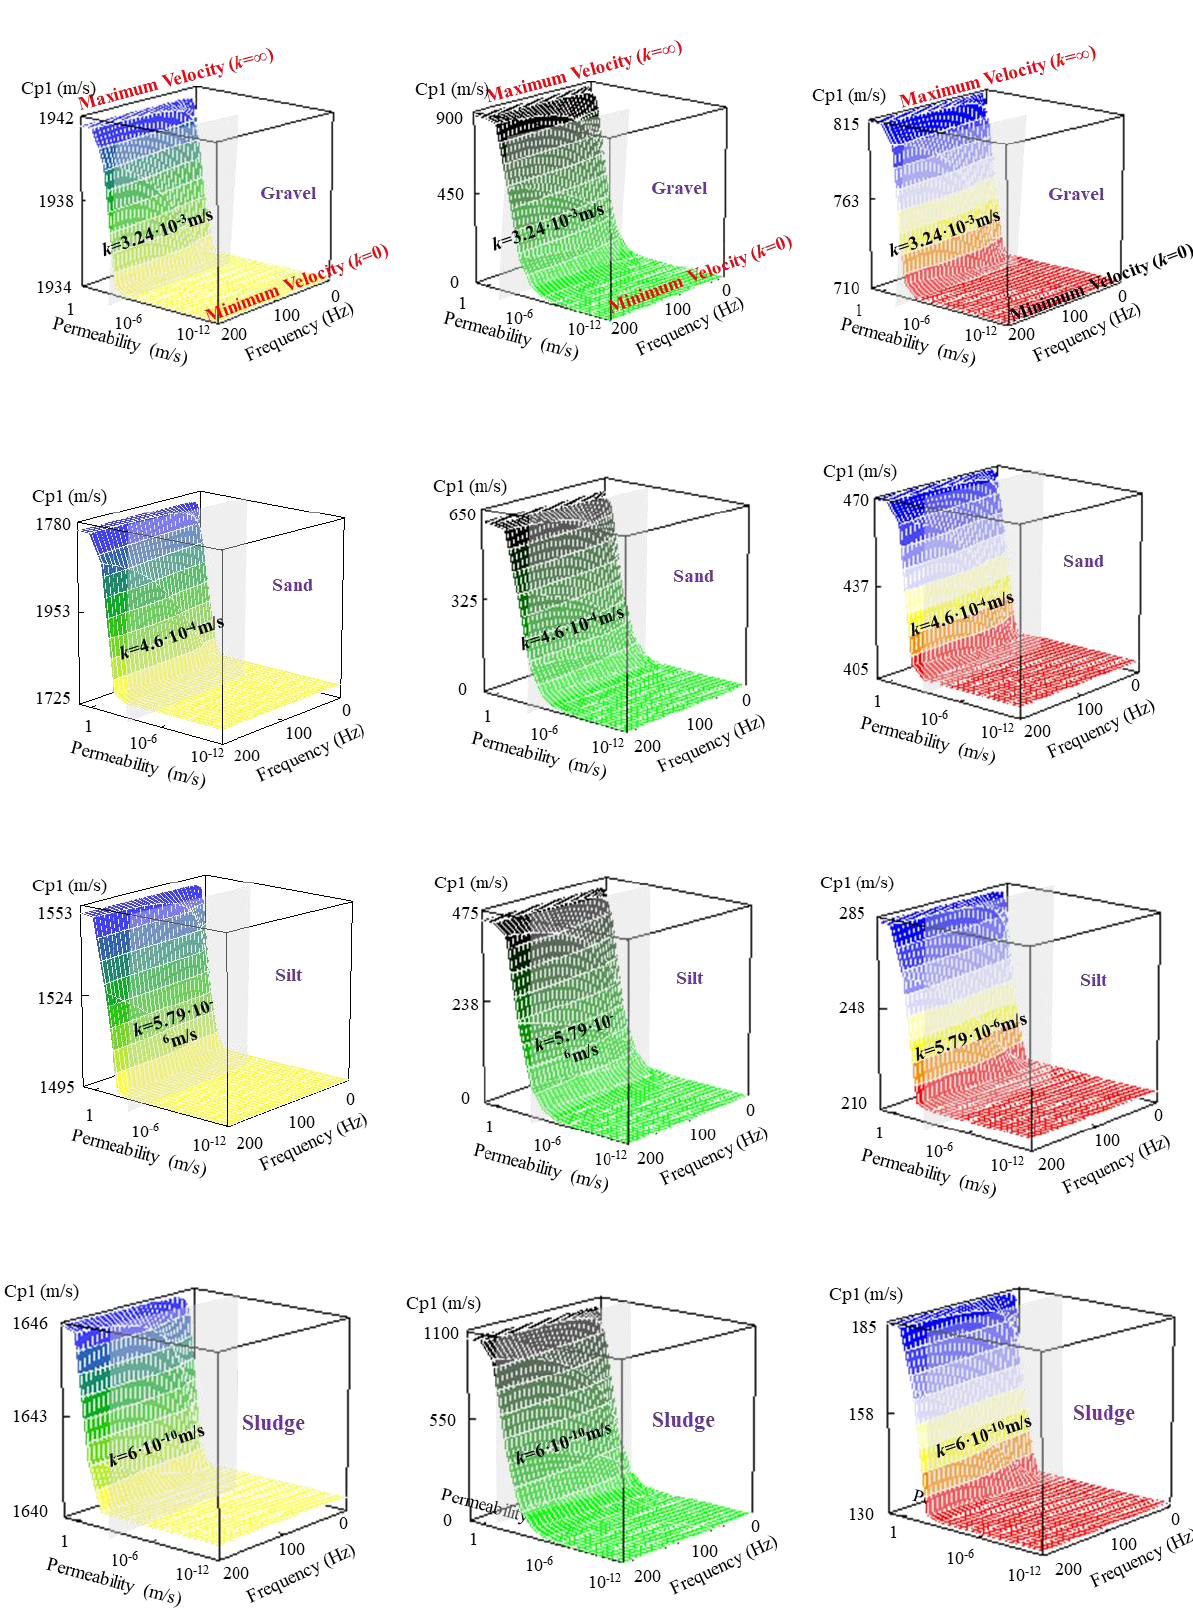
Figure 1. Relations of permeability, frequency and the velocities of three waves in four saturated soils.